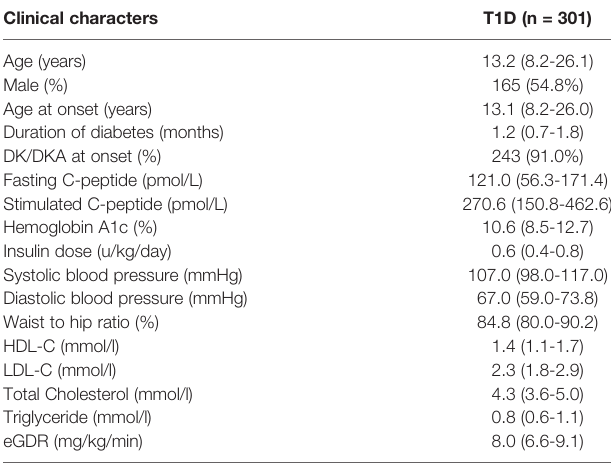
TABLE 1 | Characteristics of study participants at